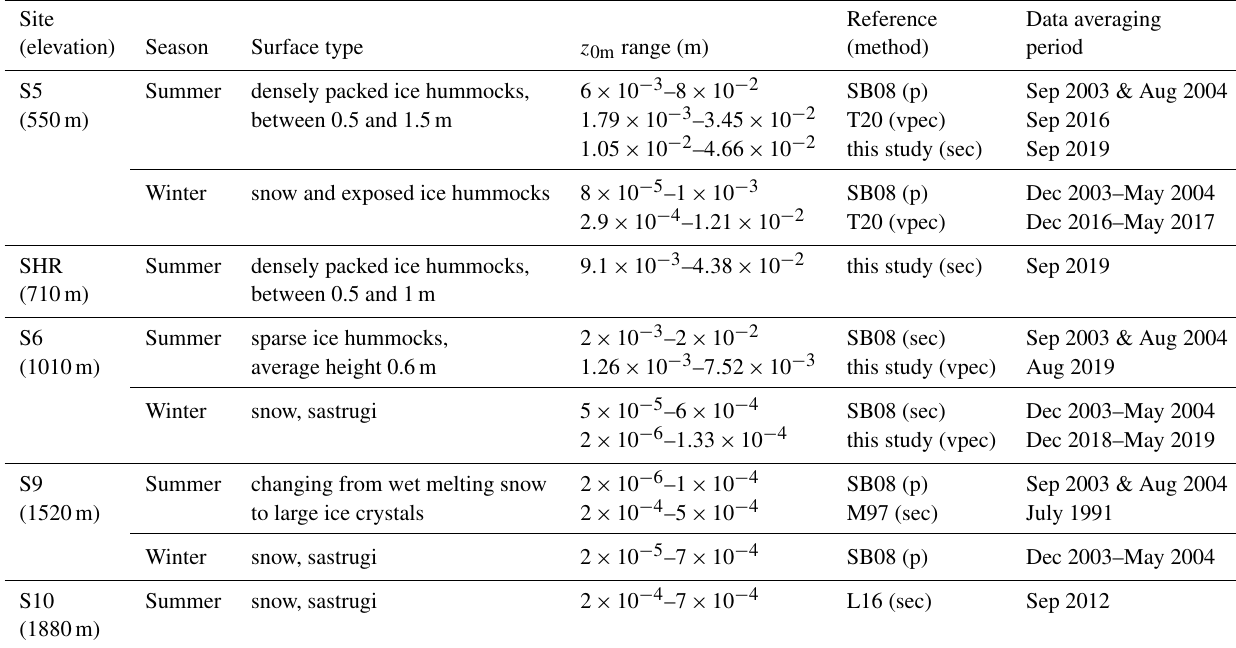
Table 1. Description of z 0m in situ datasets on the K-transect. The data from Meesters et al. (1997), Smeets and Van den Broeke (2008), Lenaerts et al. (2014), and Van Tiggelen et al. (2020) are denoted M97, SB08, L14, and T20 , respectively. The measurement methods are (p) profile, (sec) sonic eddy covariance, or (vpec) vertical propeller eddy